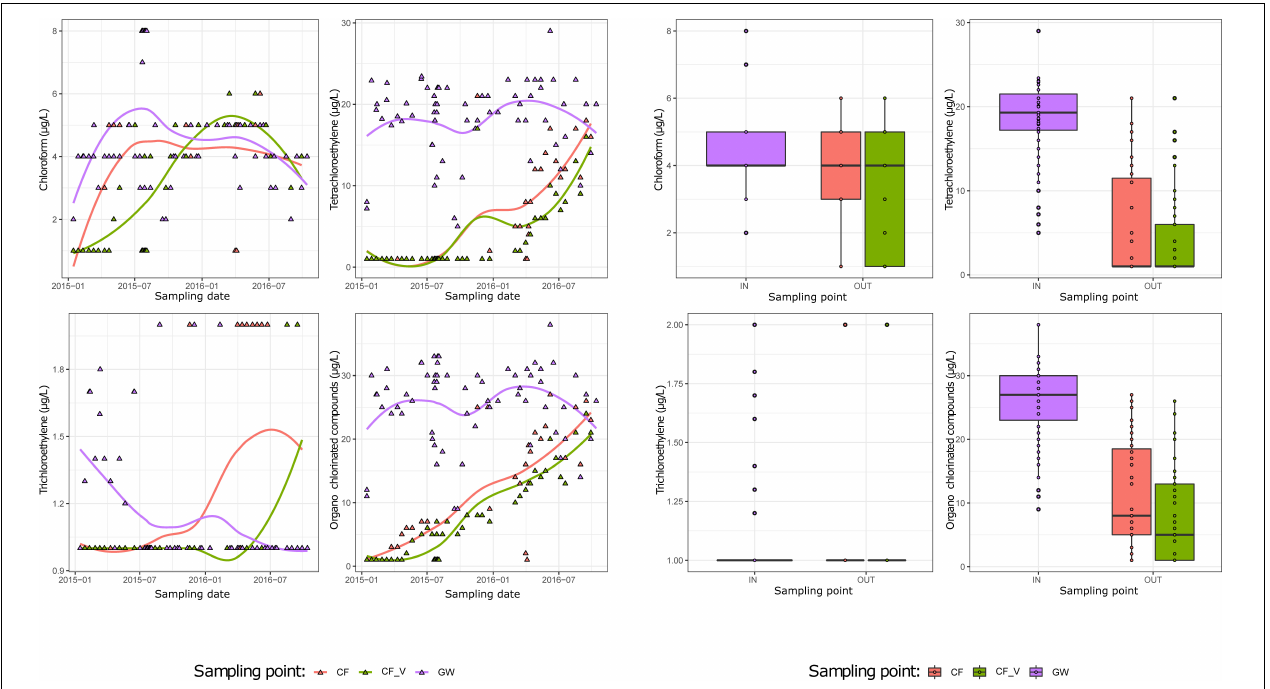
FIGURE 2 | Main organic molecules (chloroform, tetrachloroethylene, trichloroethylene and organo-chlorinated compounds) measured in GW, CF, and CF_V samples, showed per sampling date (left panel) and per sampling point (right panel).